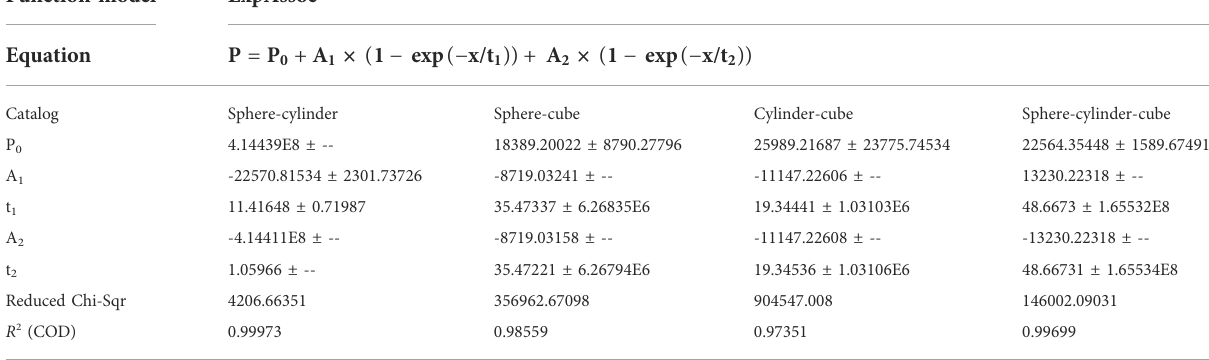
TABLE 2 Fitting function model of normal pressure maximum P